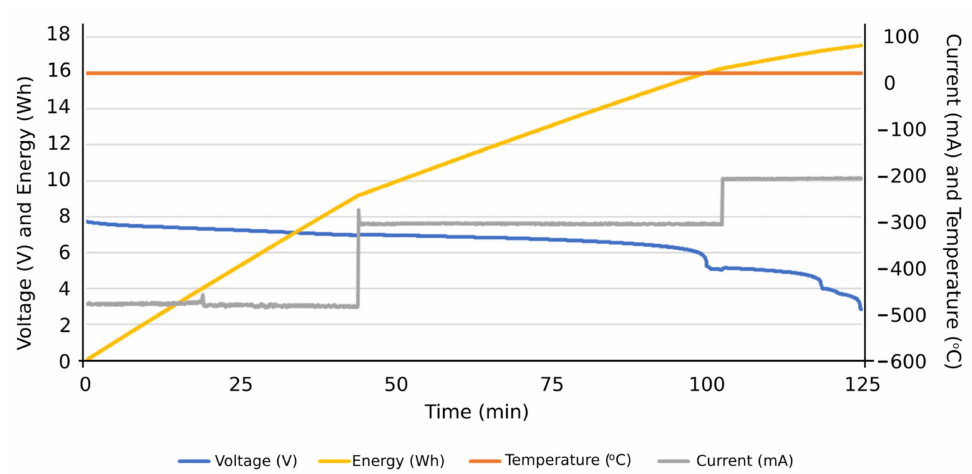
Figure 16. Results of a discharging cycle at different constant intensities: 500 mA, 300 mA, and 200 mA.